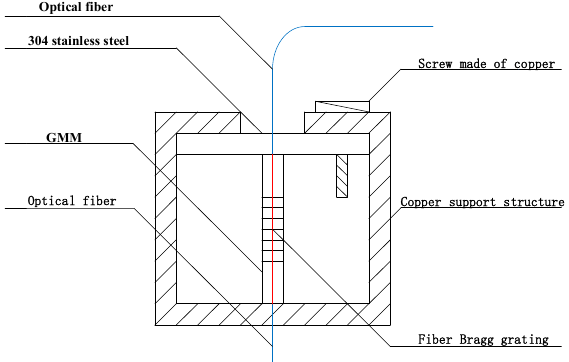
Figure 3. The sensor probe of this sensitivity-enhanced fibergrating current sensor. The central wavelength of the FBG is about 1550 nm.